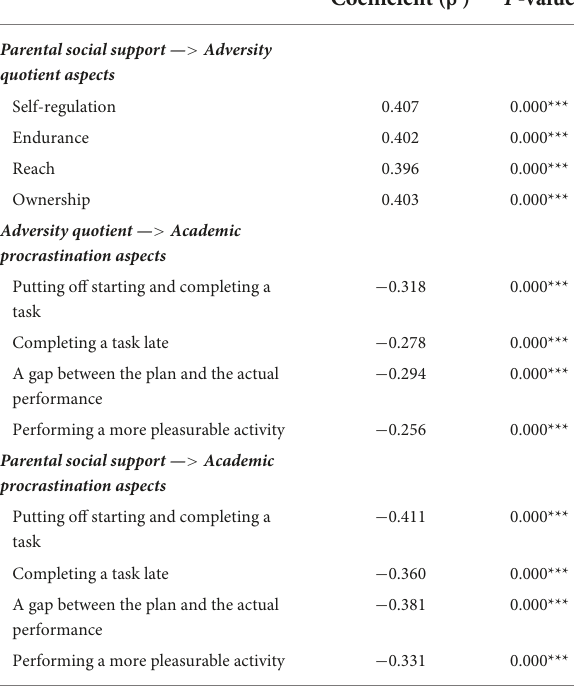
TABLE 6 Results of regression test on the aspects of the